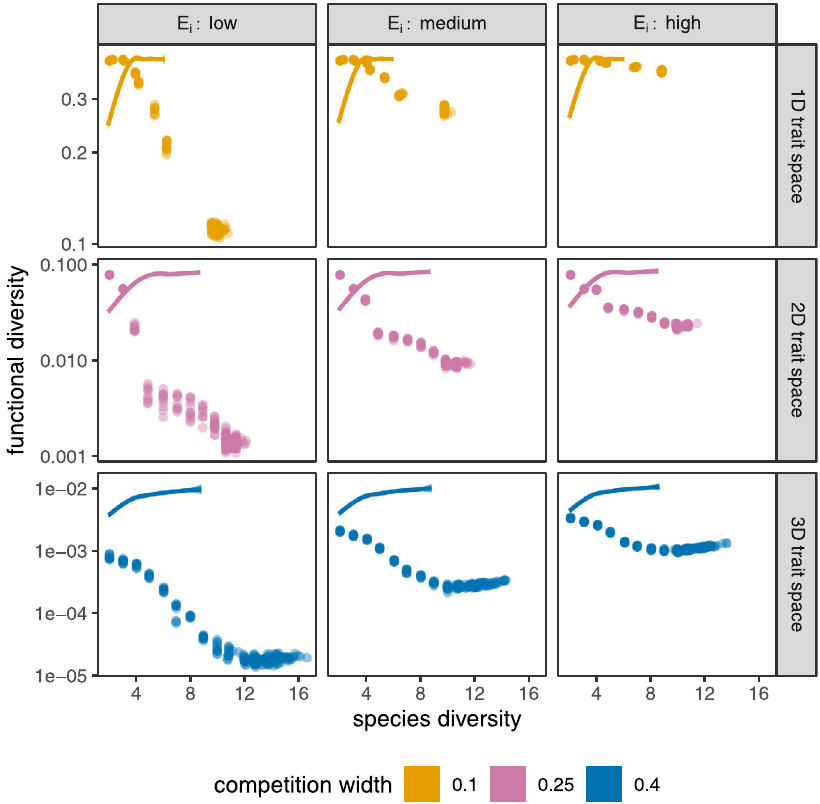
Fig. 3 Functional diversity plotted against species diversity, for various dimensions of trait space (rows), levels of environmental trait variance (columns), and competition widths (colors). Each point is a single replicate model run, across 10 replicates per parameterization; n = 240 independent samples per panel. Functional diversity was obtained by dividing each trait dimension into 101 equally-sized bins in the [ − 1, 1] range (Supplementary Note 5; note the log scale along the ordinate). Since higher-dimensional trait spaces have more room and therefore can harbor more species all other things equal, the competition widths were chosen larger for higher-dimensional trait spaces to create comparable species diversities for different trait dimensions. The lines in each panel are locally weighted polynomial regression fi ts on corresponding results from an appropriate null model with 99% con fi dence intervals around them (these errors are so small that they are barely visible). The null model consists of an exact re-run of the replicates, with the sole difference that the trait covariances are not allowed to evolve. In the null model, the relationship between species- and functional diversity is positive, as expected. They do not reach as far along the x axis because without the trait breadths being allowed to shrink, only fewer species can be packed into the trait space, limiting species